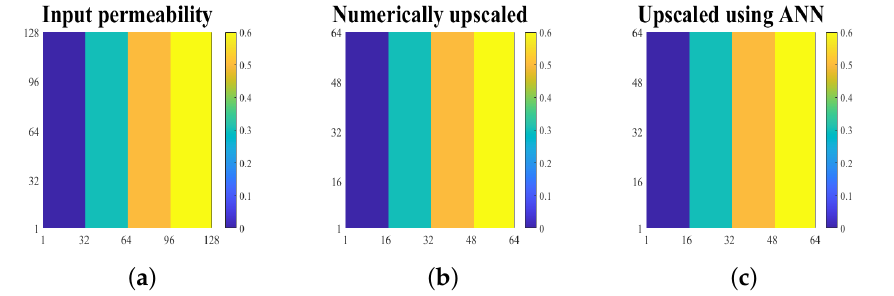
Figure 13. ( a ) Input layer cake permeability distribution on a 128 × 128 grid size. ( b ) The numerically upscaled permeability field on a grid of 64 × 64 grid cells. ( c ) The neural upscaled permeability field on a grid of 64 × 64 grid cells.